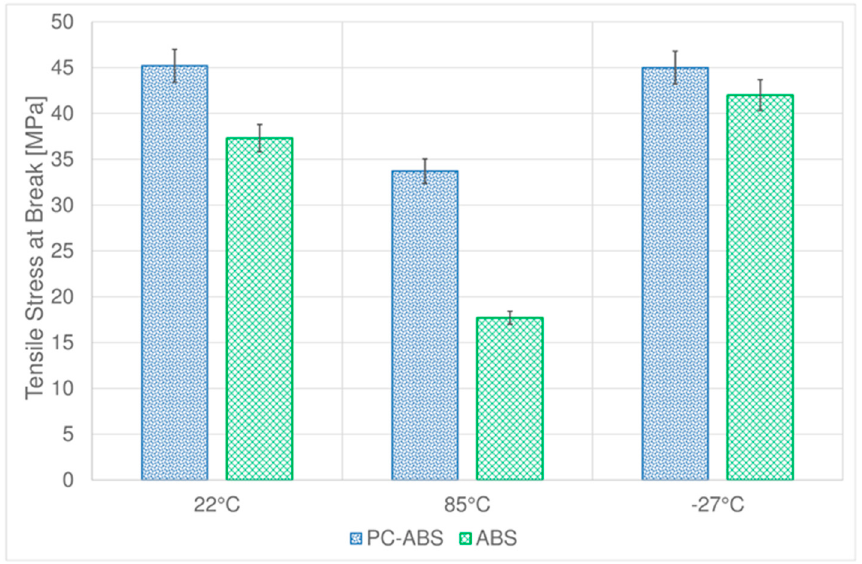
Figure 5. Comparison between tensile stress at break of PC-ABS and ABS at different temperatures.